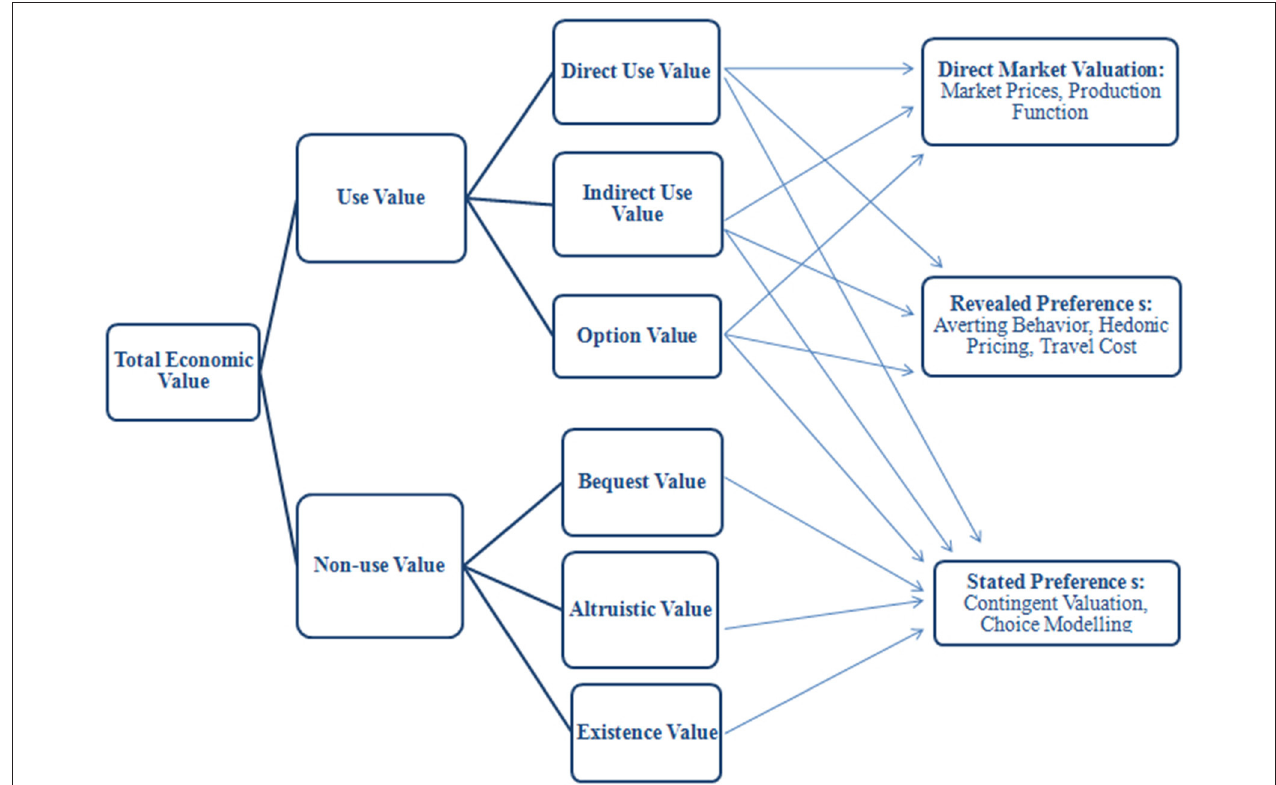
FIGURE 1 | Total economic value framework (Bertram and Rehdanz,